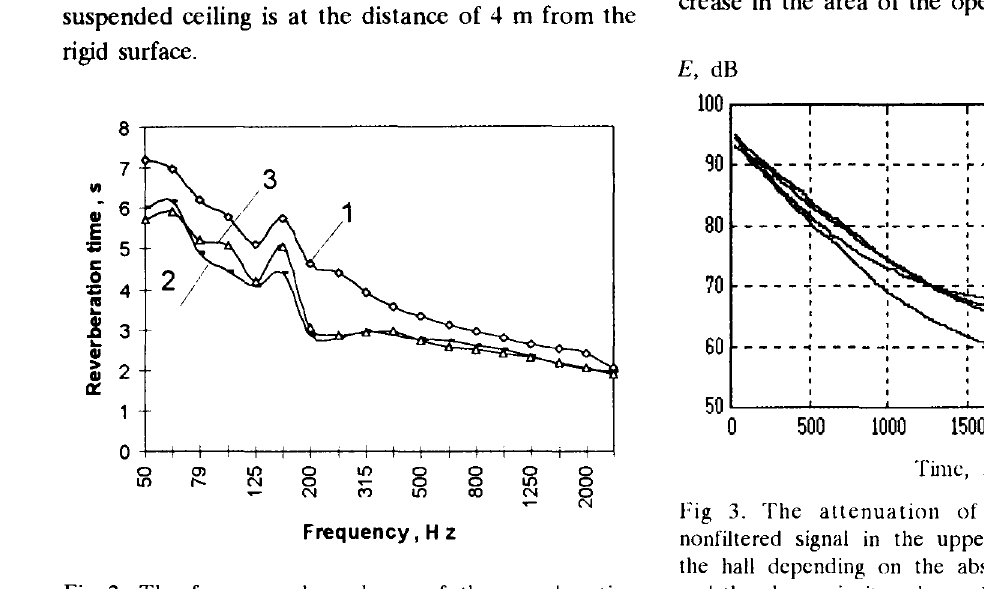
Fig 3. The. attenuation of the sound energy of a nonfiltered s1gnal in the upper and the lower bodies of the hall depending on the absorption in the upper body Fig 2. The frequency-dependence of the reverberation and the change in its volume. 1 and 2 - in the lower body v! and the upper body v2 respectively, when there is no time in the halls with varied volumes. 1 - without sus pended ceiling, V = 9000 m 3; 2 - for the lower body, with sound-absorbing material above the suspended ceiling; 3 the suspended ceiling and V and 4 - same with the sound-absorbing material above the = 8273 mJ; 3 - same for the 1 upper body, when V = 748 mJ suspended